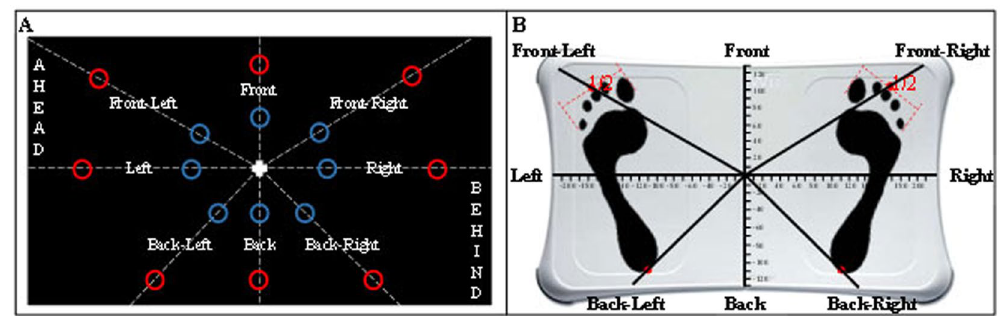
Figure 5. Axes and targets. ( A ) Location of the 16 targets on each of the 8 locations, for easy (blue targets) and hard (red targets) difficulty levels. Note that targets appeared only in green during the experimentation. ( B ) Measurement of individual support polygon for personalized theoretical stability limitations and directions